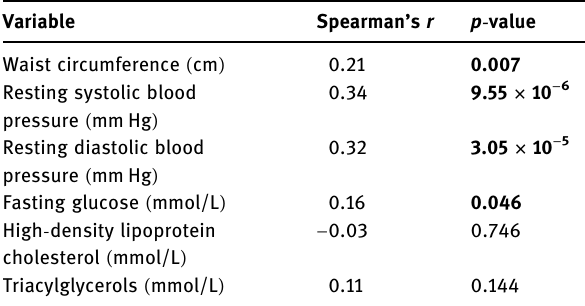
Table 2: Correlations between HCC and criteria of metabolic syndrome